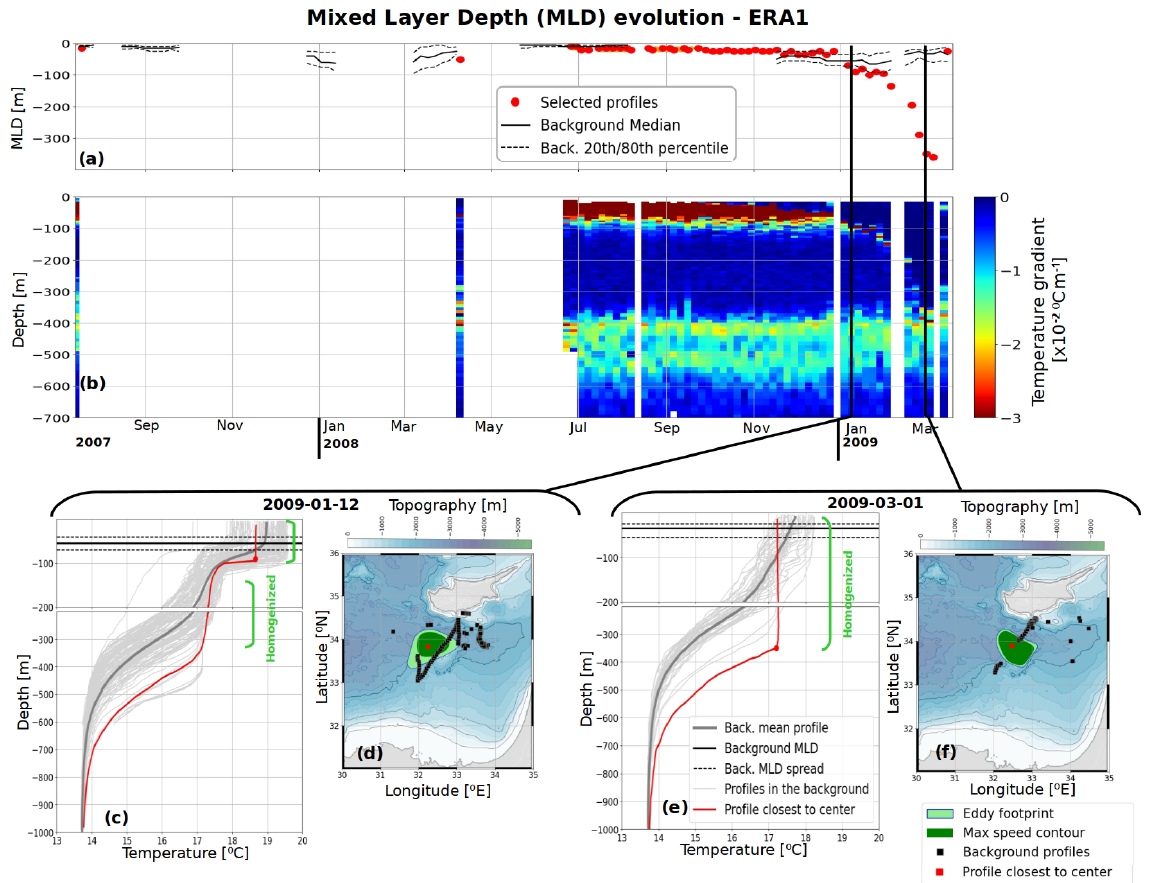
Figure 4. In-depth evolution of an Eratosthenes anticyclone, listed as “ERA1” in Table 1. (a) MLD evolution, with continuous black line for background MLD (and dashed line for associated spread between 20th and 80th percentiles) and red dots for the anticyclonic core MLD closest to eddy centre. (b) Time series of inside-eddy temperature gradient, blue showing homogeneous and red showing stratified layers; (c) (respectively e ) shows vertical profiles around 12 January 2009 (1 March 2009) with background profiles in thin grey lines, background mean as thick grey line, inside-eddy profile as red line, a red dot highlighting anticyclonic core MLD and a green bar indicating homogenized layers (temperature gradient below 2 . 5 × 10 − 3 ◦ Cm − 1 ). Horizontal continuous and dashed black line refer back to background MLD and spread from panel (a) ; (d) (respectively f ) shows profiles’ corresponding position on a map with same colour code together with the eddy maximal-speed contour (dark green shape) and eddy footprint (outermost closed SSH contour, light green shape). Bathymetric data are from ETOPO1 (Smith and Sandwell,